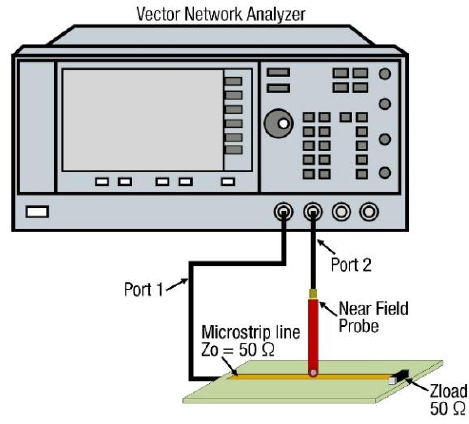
Figure 5. Description of the measuring setup.